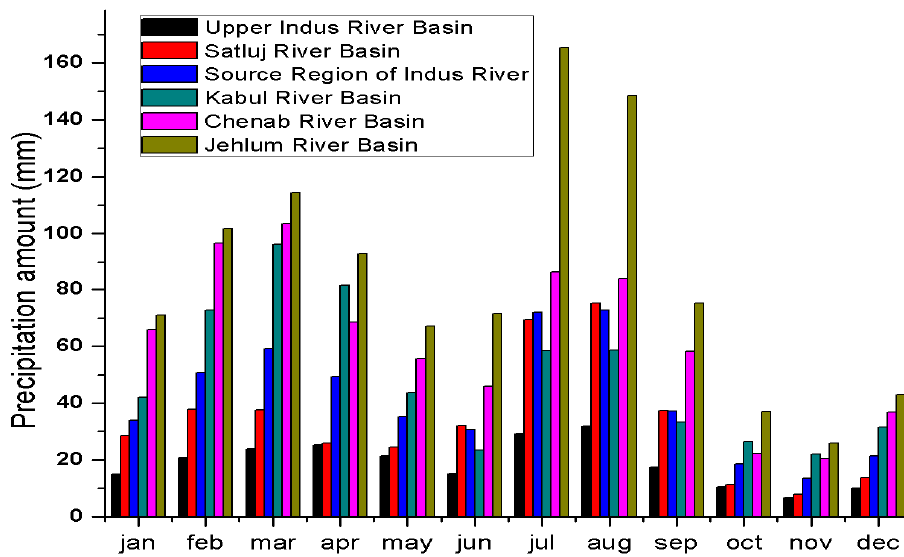
Figure 4. Averaged monthly precipitation in the study area and its river basins from 1961 to 2015.